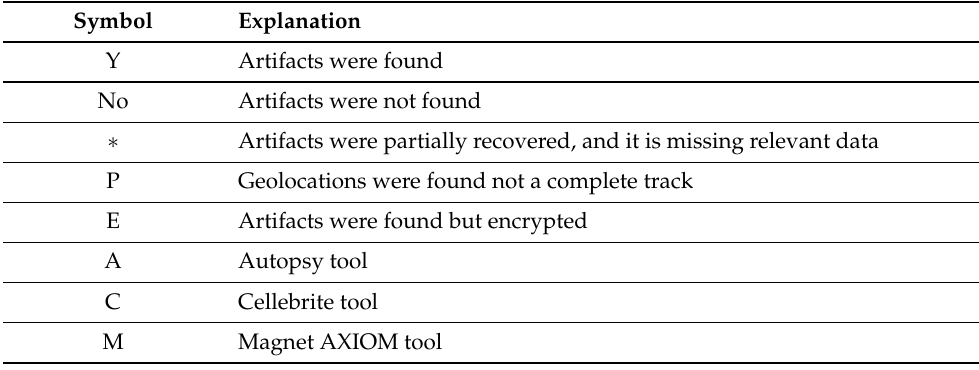
Table 2. Explanation of symbols used in Table